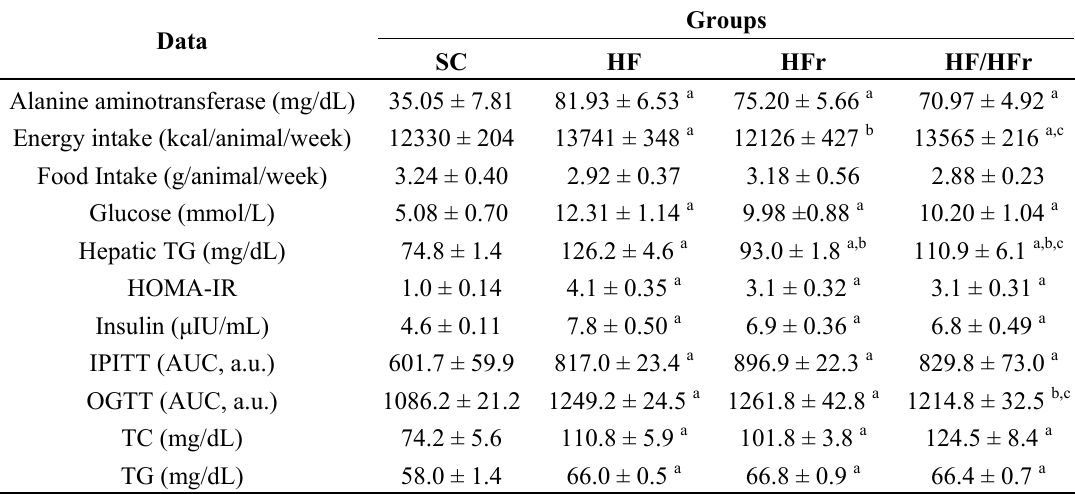
Table 1. Food intake and plasma biochemical responses. Values are means ± standard error. Symbols represent significant differences from a SC, p ≤ 0.05; b HF, p ≤ 0.05;